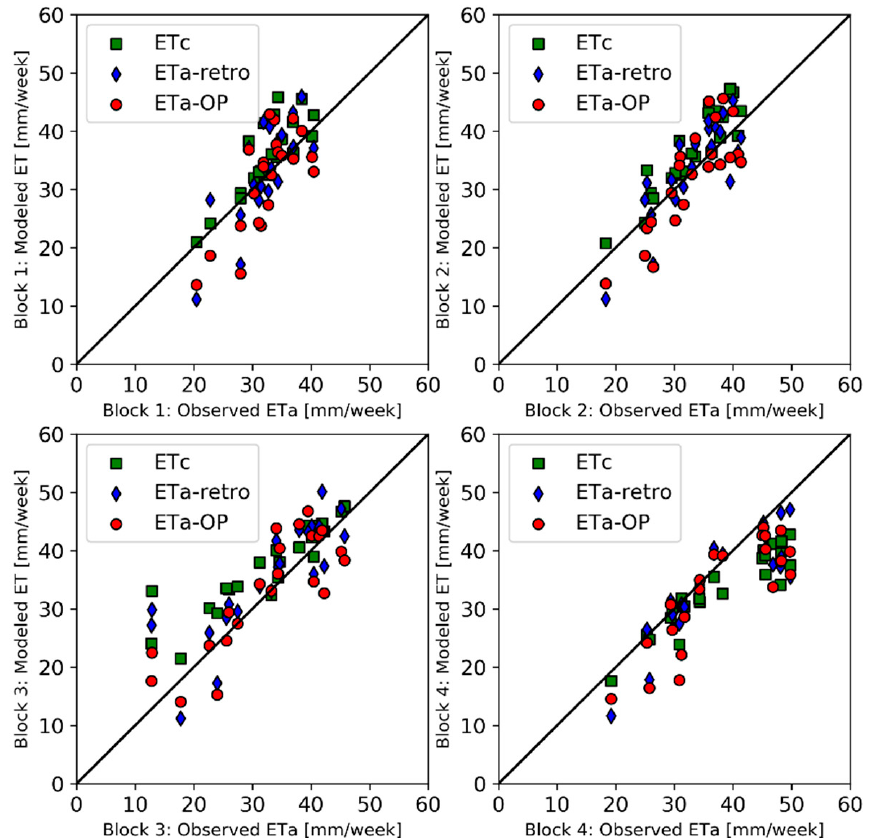
Figure 3. Scatterplots comparing observed (closure corrected) and modeled weekly ET (mm week − 1 ) from the baseline retrospective DisALEXI + fusion model (ET a -retro) run, operational DisALEXI + fusion model (ET a -OP) and the modified FAO-56 (ET c ) model for blocks 1, 2, 3 and 4 (top to bottom, left to right).